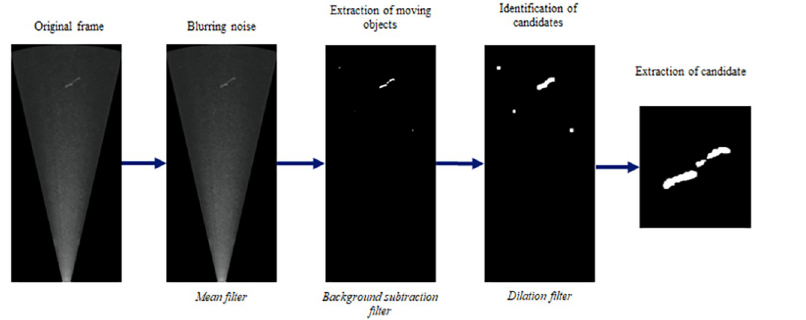
Fig 3. Workflow of the third step of the method carrying the detection of the